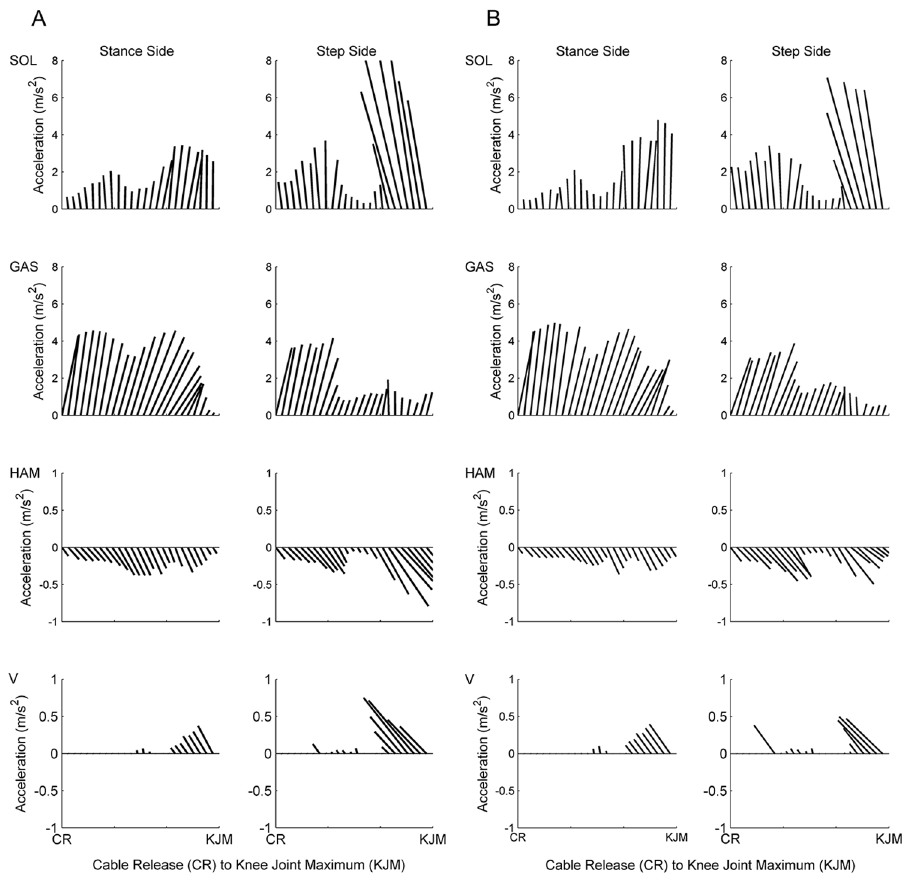
Fig 4. Vector plots representing the muscle induced accelerations of key muscles from the stance and stepping side limbs for older adults (A) and younger adults (B) from cable release(CR) to knee joint maximum (KJM) during balance recoveryby stepping. Each line representsthe resultant vector of the vertical and anterior-posterior acceleration inducedby the respectivemuscle on the COM. The vertical and horizontal axis of each plot are scaled